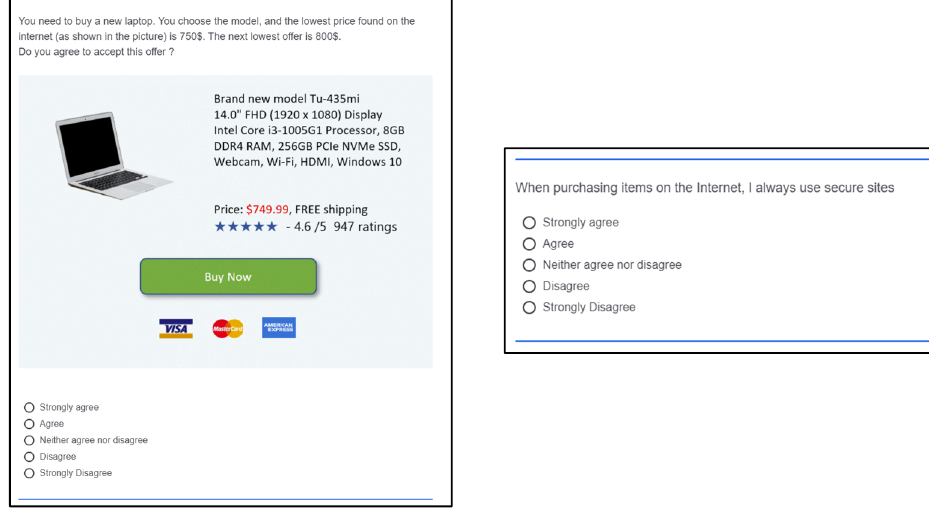
Figure 3. Evaluating privacy concern vs. privacy behavior when using secure web sites when purchasing goods with an e-commerce transaction.